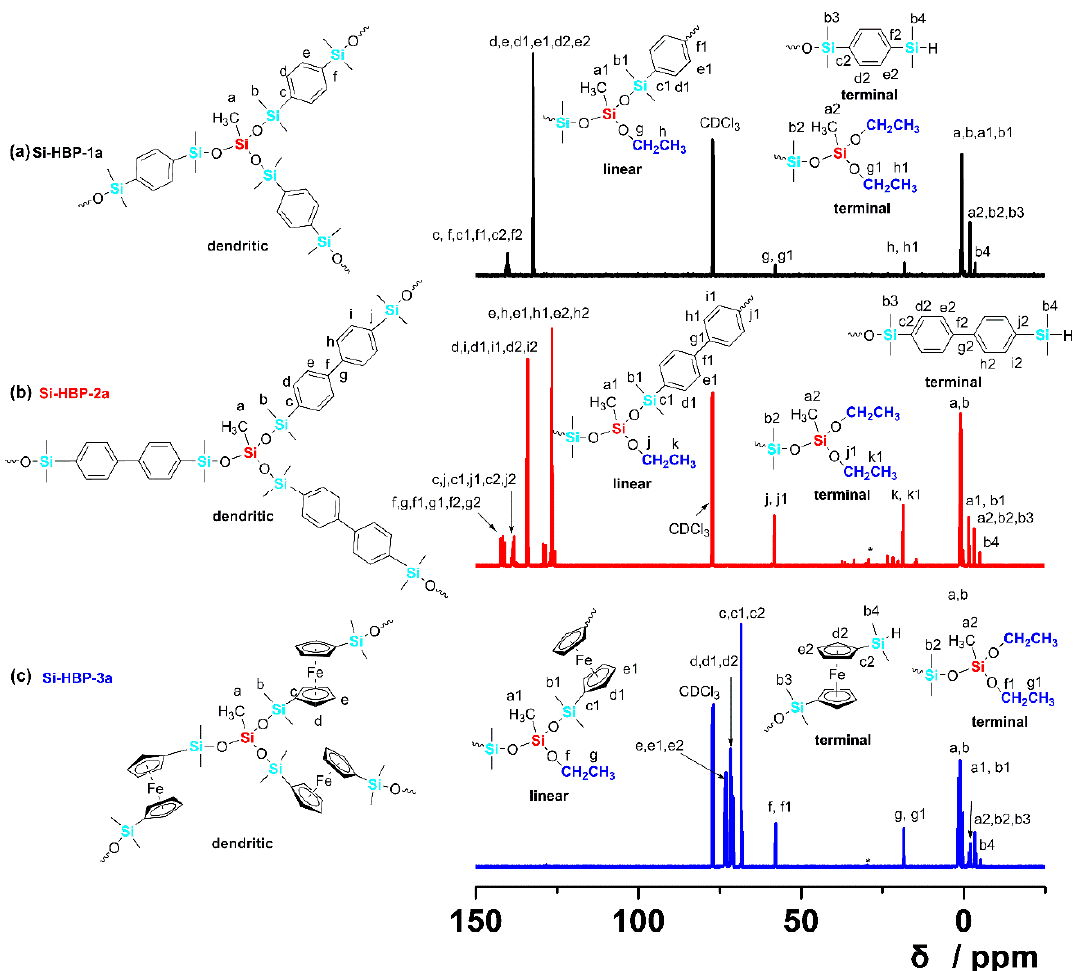
Figure 3. 13 C NMR spectra of Si-HBP-1a ( a ), Si-HBP-2a ( b ) and Si-HBP-3a ( c ). The asterisk denotes the residual toluene in the product.